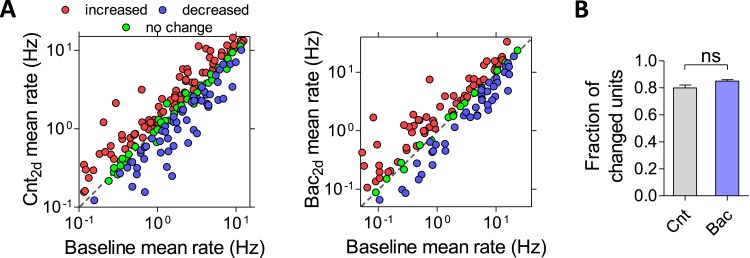
Firing rate homeostasis is not precise at the level of multi-units.(A) Per unit correlation between baseline firing rates and firing rates after 2 days: Left: control (n = 7; 192 multi-units); Right: in the presence of baclofen (n = 5; 133 multi-units). Colors represent units that significantly increased (red), decreased (blue), or remained stable (green) as determined by bootstrapping (see ‘Materials and methods’ for details). Note log scale of both axes. (B) Summary of data in (A) (unpaired, two-tailed Student's t-test). Error bars represent SEM.